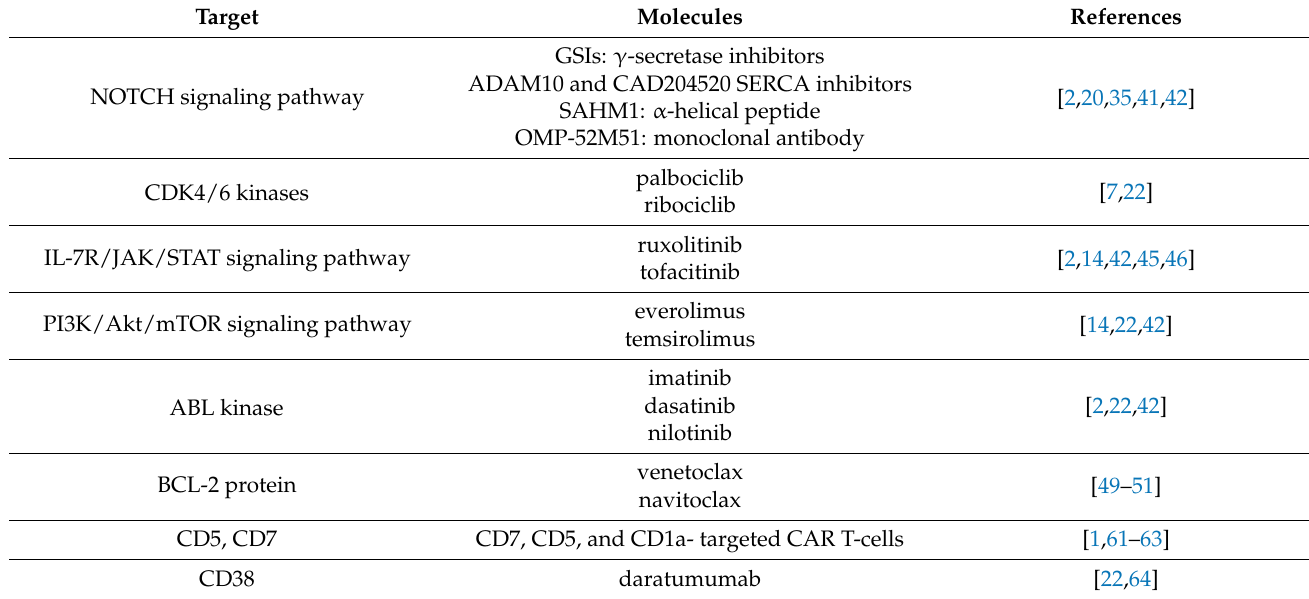
Table 2. Promising targets and molecules in novel T-ALL therapies. Target